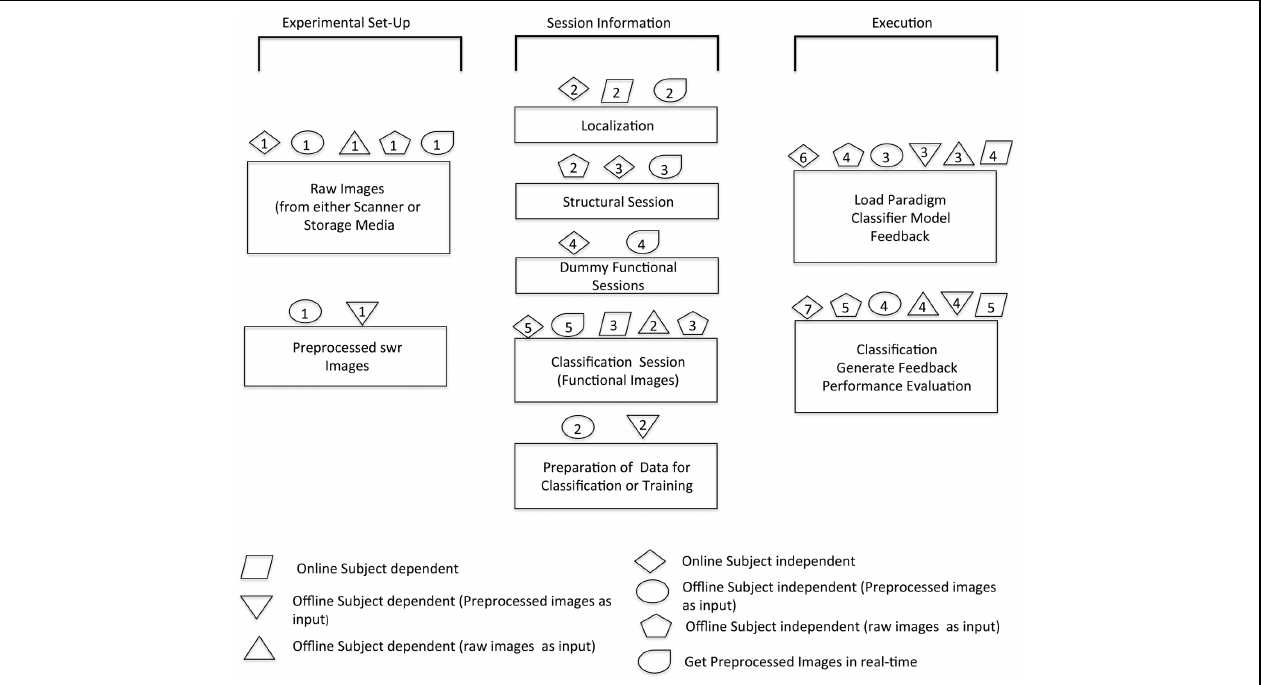
FIGURE 5 | Overview of software architecture for various modules. The schematic shows the possible options of analysis that can be done with the help of this toolbox. The sequence in which different steps are performed in order to execute specific modules is illustrated by corresponding symbols.